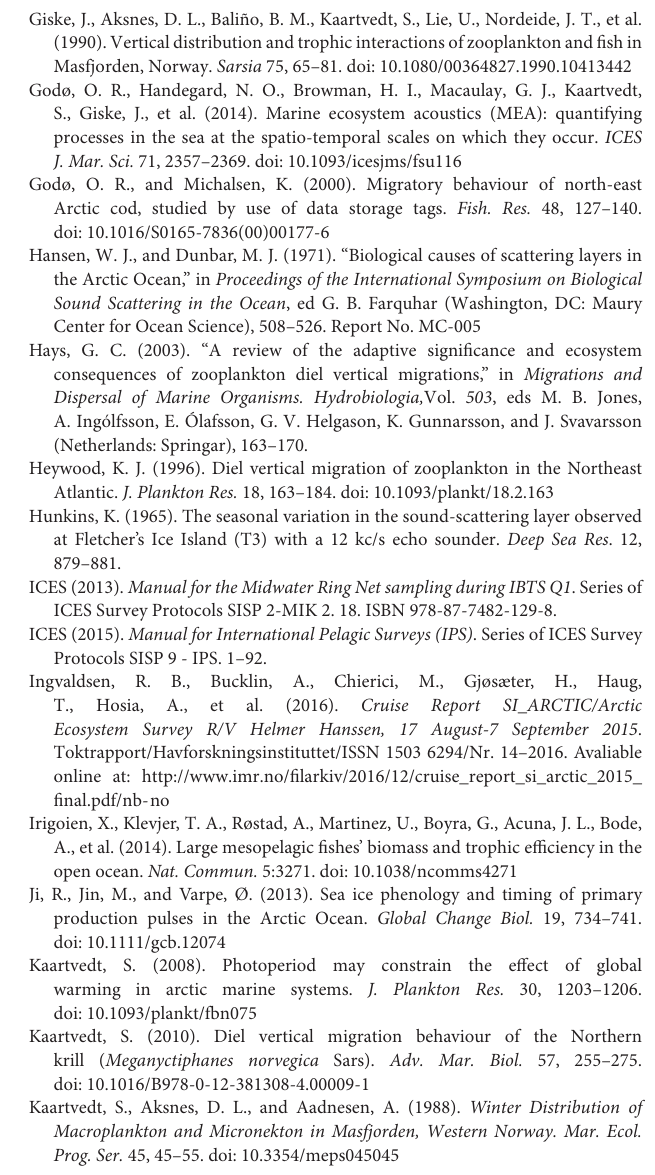
Figure S1 | Theoretical daily cycle of solar elevation above/below the horizon at the date and location of the experiments: Sofia Deep N and Sofia Deep S (at August, and in Northern Fram Strait (78 ◦ 40 ′ N) on 1, 2, and 3 September 2015. Figure S2 | Vertical profiles of fluorescence (black line) and turbidity (blue line), both measured with Seapoint sensors on the CTD, in the upper 200m at the eight locations where diel vertical migration of the DSL was studied. Note a different fluorescence scale for the profile from Sofia Deep N compared to the